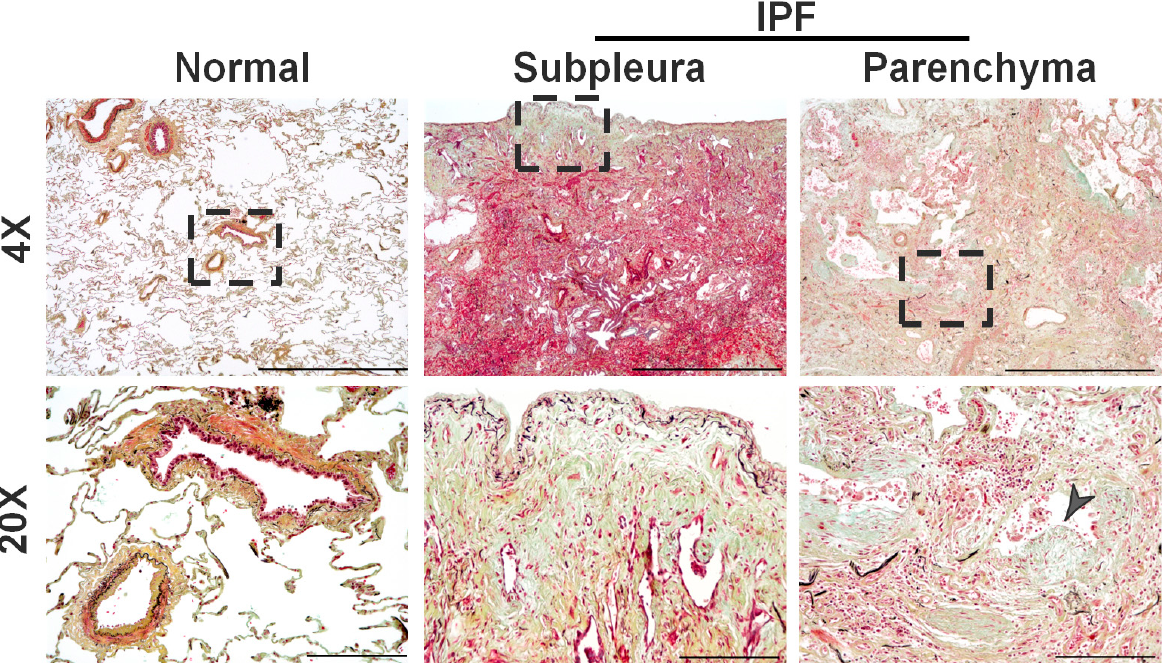
Figure 1. Representative images of Movat Pentachrome-stained distal areas of normal and IPF lungs. Highlighted dashed region in low magnification (Scale bar, 1500 µm) images represents the high magnification (Scale bar, 200 µm) images that show the prominent subpleural thickening and fibrotic foci that accumulate in the distal areas of the alveolar parenchyma of IPF lungs compared to normal lungs. Pentachrome staining highlights collagen (yellow color), muscle (red color), and elastic fibers (black to blue color) in mature fibrotic lesions of IPF. Arrowhead is used to highlight the fibrotic foci.